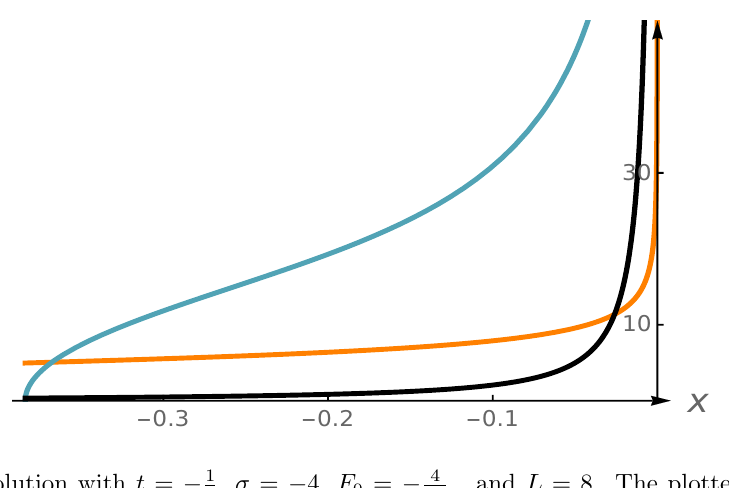
Figure 3 . A solution with t = (cid:0) 1 e W (orange), e (cid:30) (black) and e (cid:21) 1 (turquoise). On the left ( x 0 = (cid:0) 0 : 38) the S 1 shrinks regularly, on the right ( x = 0) a diverging-dilaton O8